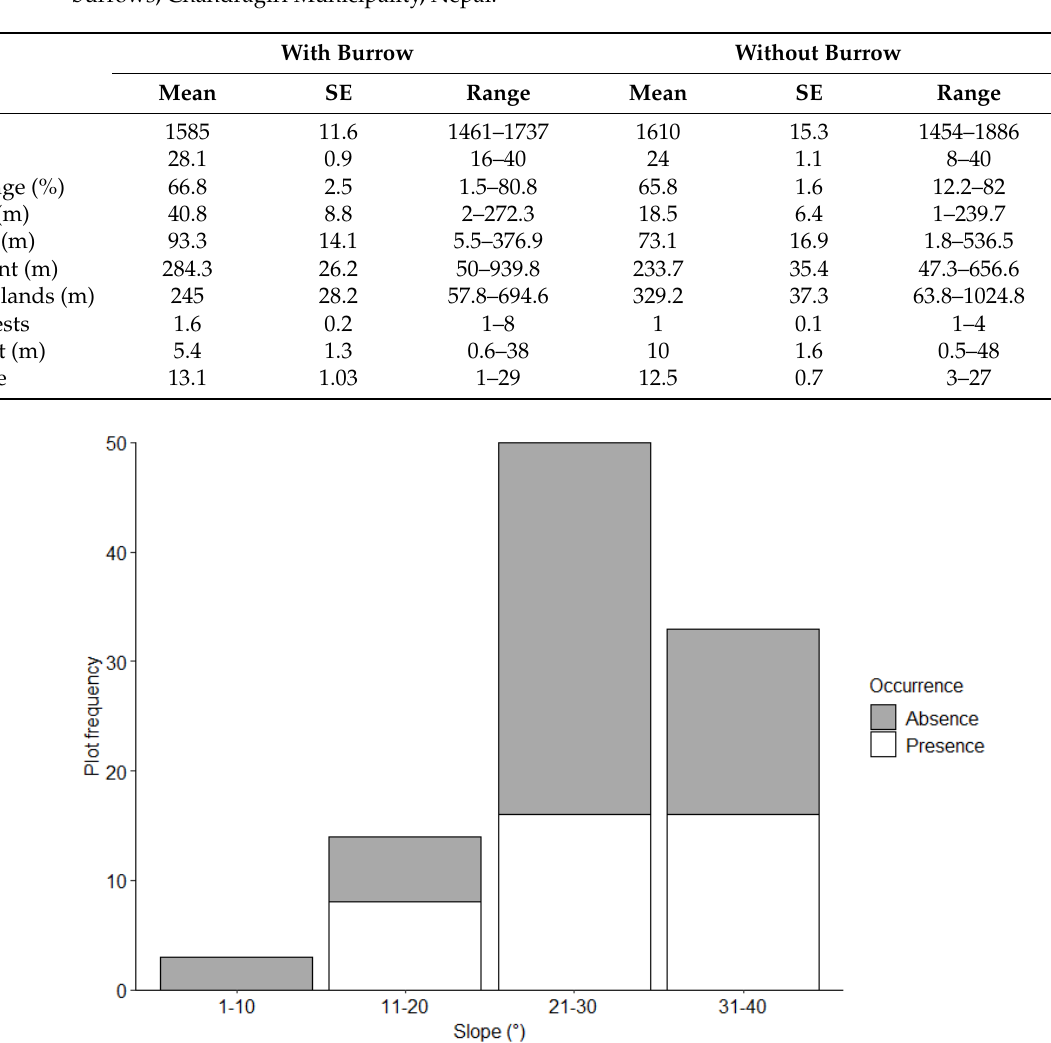
Figure 3. Chinese pangolin foraging burrow distribution by slope gradient in Chandragiri Municipality, Nepal.